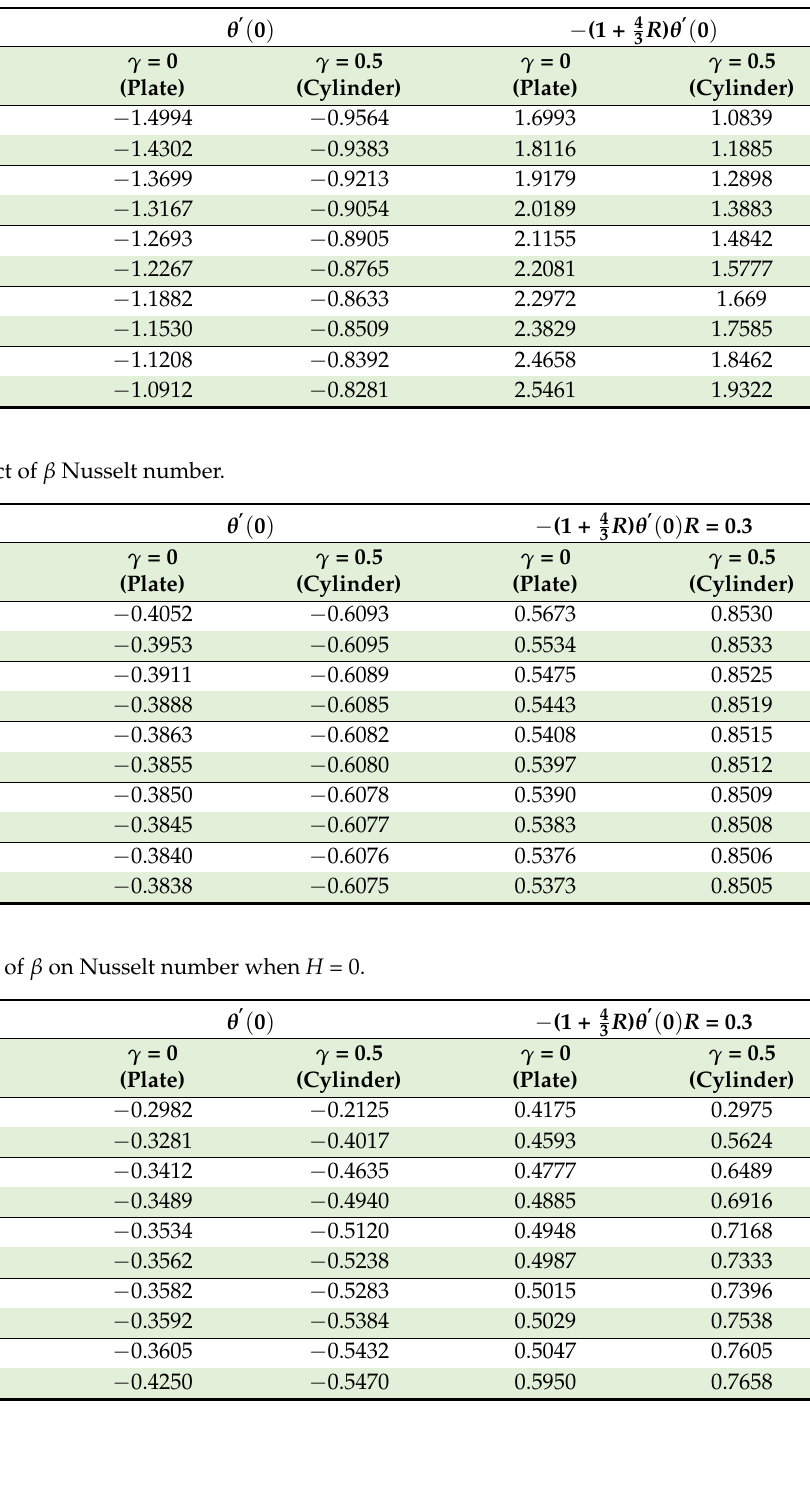
Table 6. Effect of R on Nusselt number when H = 0.